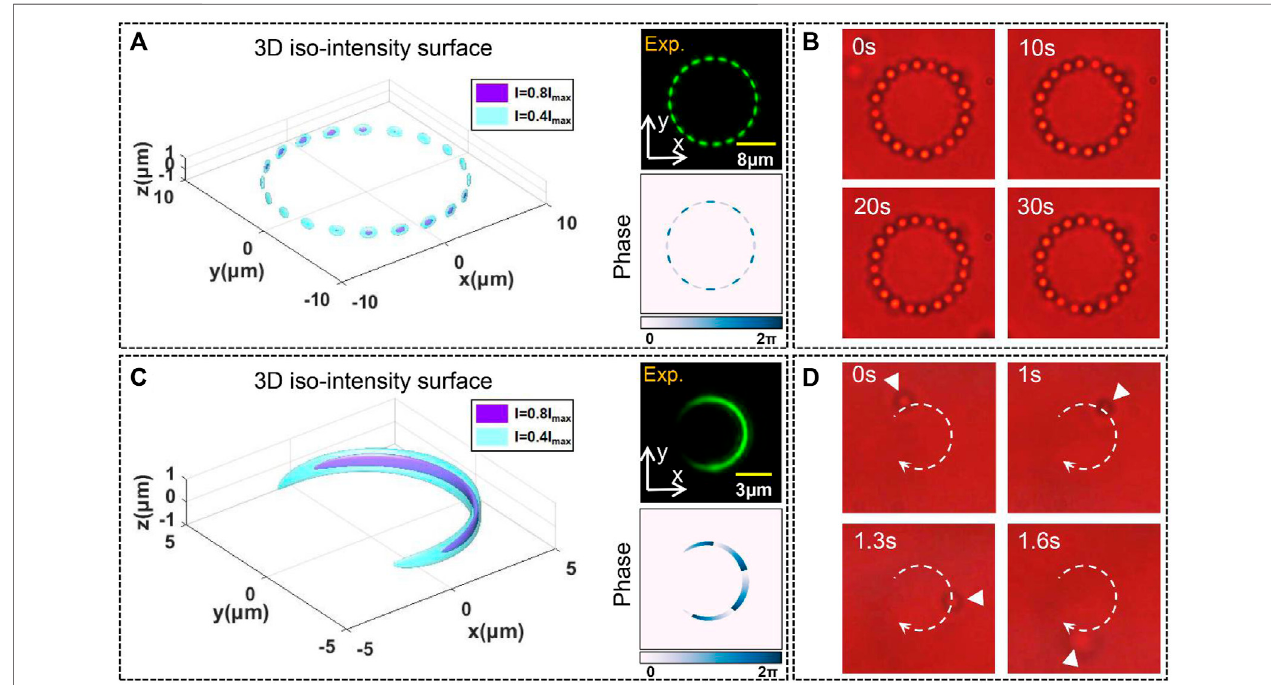
FIGURE 8 | (A,C) Intensity and phase distribution of spot array in the focal region. (B,D) Corresponding trapping